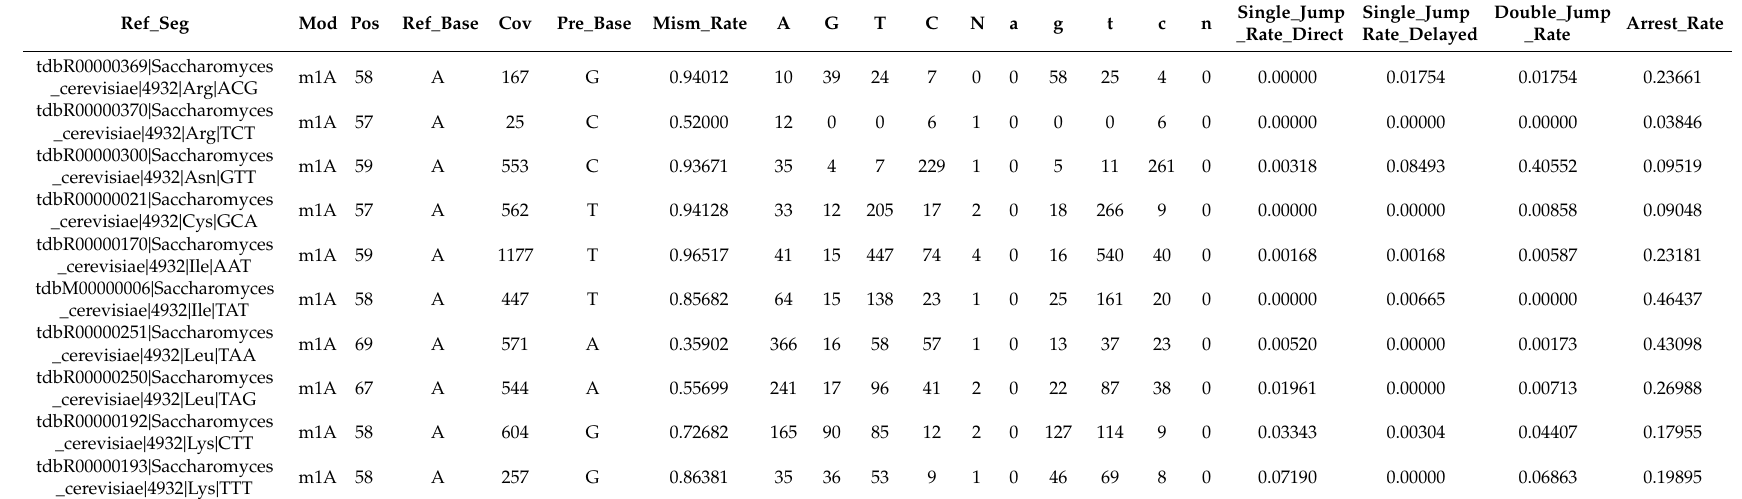
Table 1. Exemplary profile file of 10 m 1 A positions from the EpiScript reference sample after final data